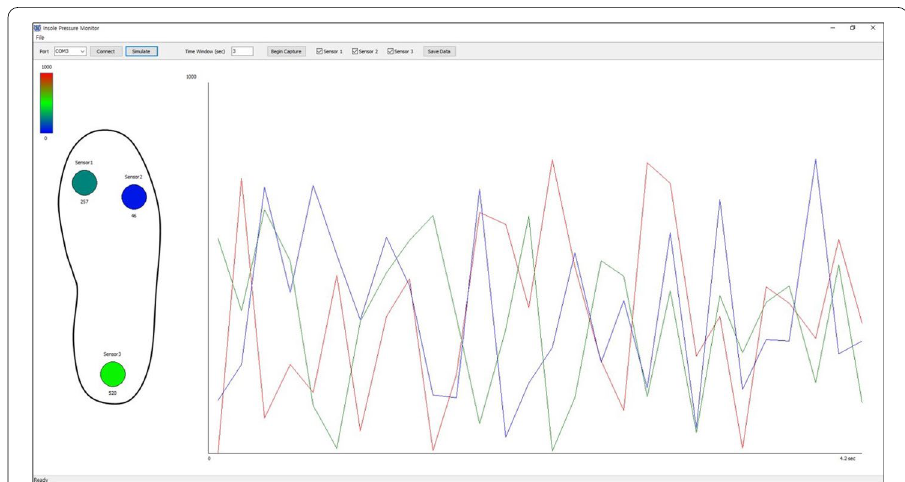
Fig. 8 Overview of insole pressure monitoring